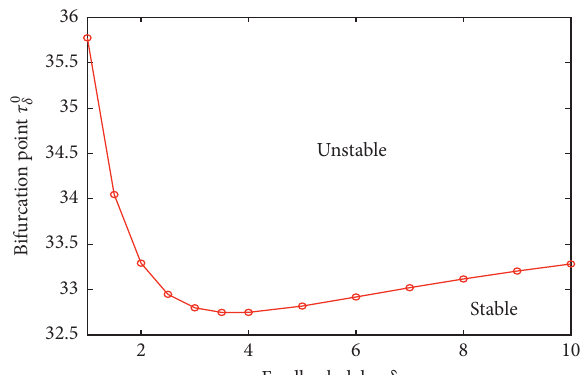
Figure 11: The impact of the extended feedback delay δ on the bifurcation value τ 0